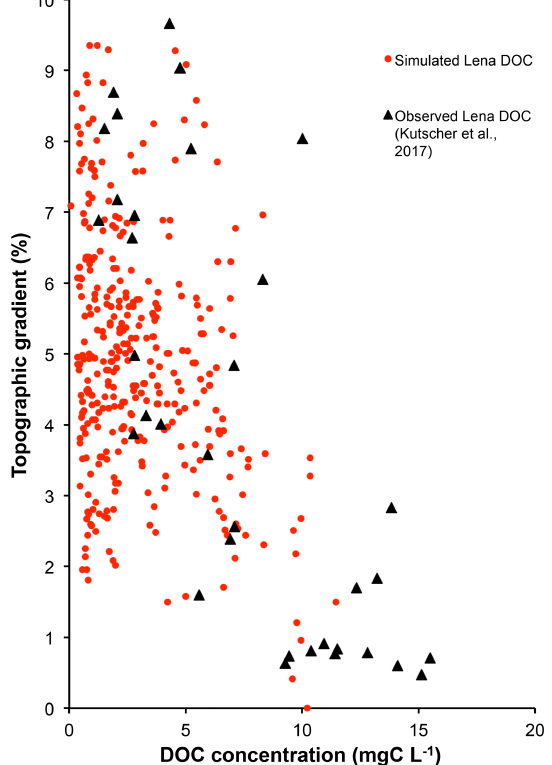
Figure 8. Variation of DOC concentrations versus topographic slope in Kutscher et al. (2017) (black triangles) and (red dots) as simulated and averaged for the summer months (JJA) over 1998– 2007; observed values were measured during June and July 2012–